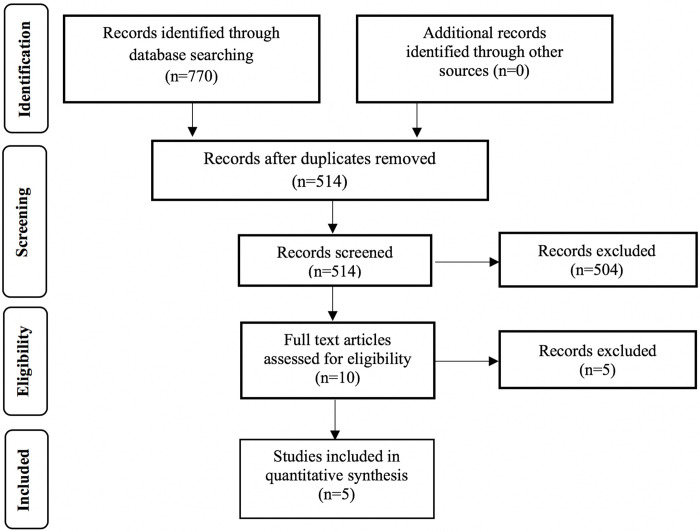
Flow of records.